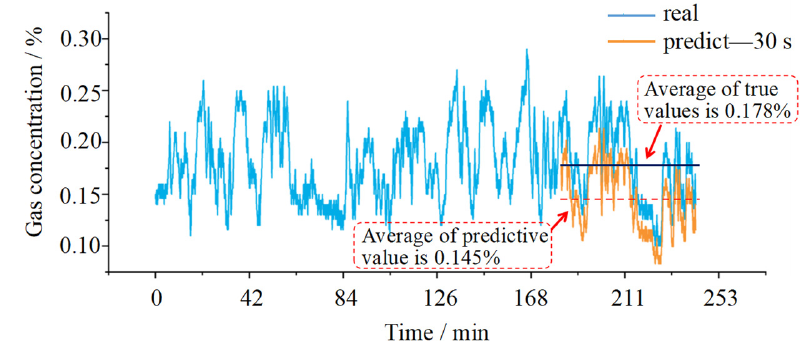
Figure 8. Gas concentration prediction of the model with an update period of 30 s.